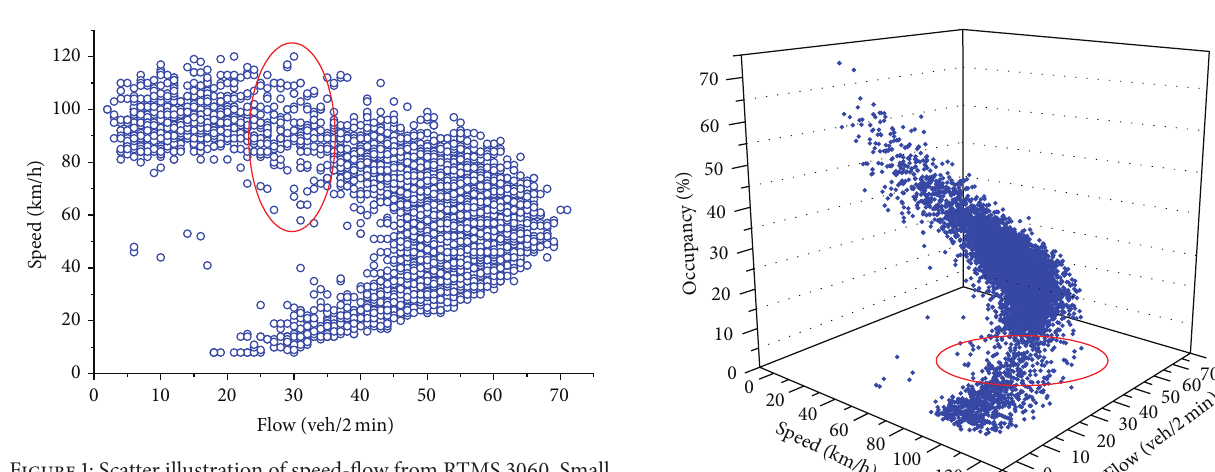
Figure 1: Scatter illustration of speed-flow from RTMS 3060. Small bluecirclesstandfortherelationbetweenspeedandflow,andthered ellipse zone stands for the joint zone linked with free and congested traffic situations. Symbols show conditions of discontinuity.